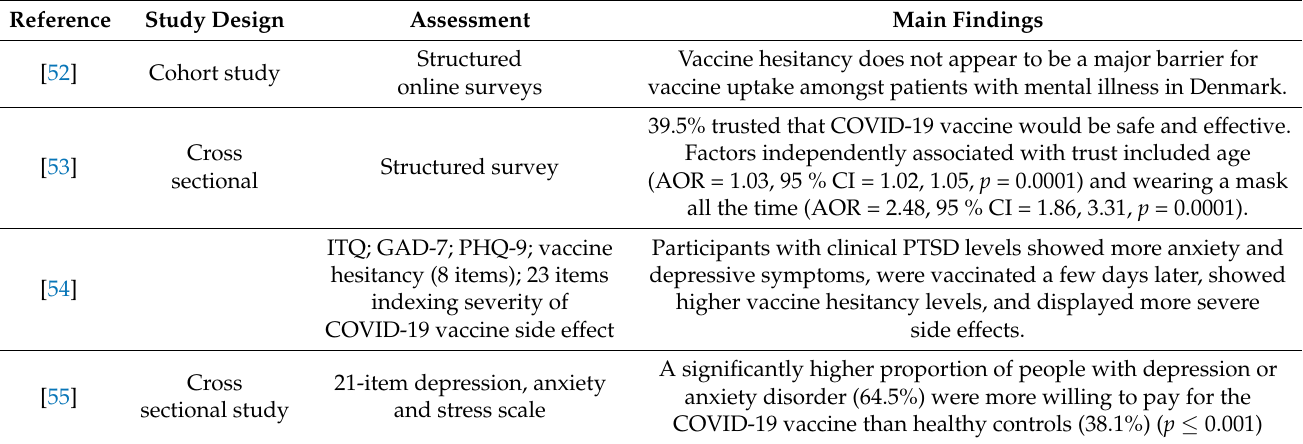
Table 1. Selected manuscripts evaluating psychiatric factors and COVID-19